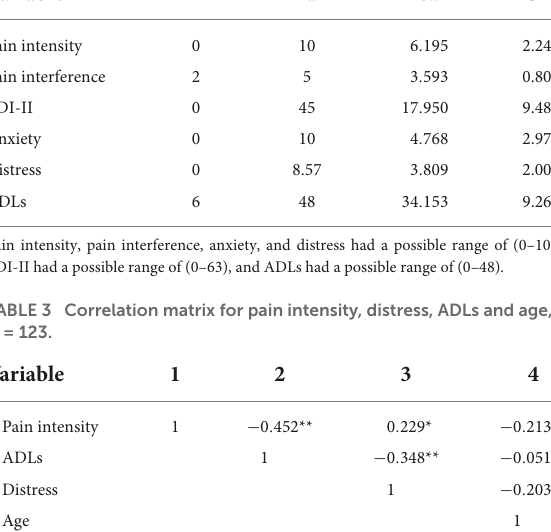
TABLE 2 Descriptives observed for pain intensity, pain interference, distress, ADLs and age, N = 123. Variable